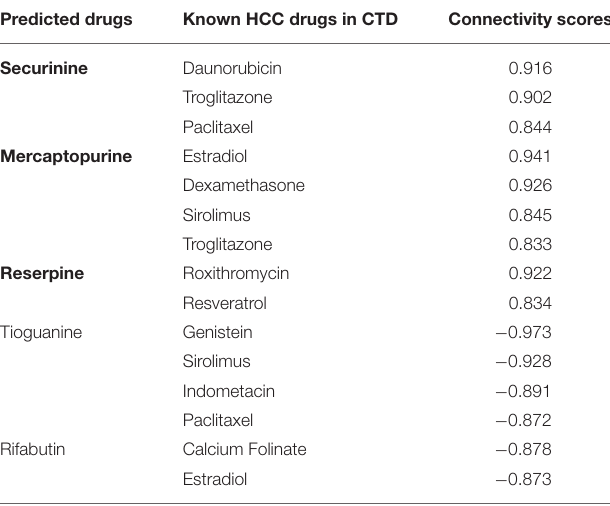
TABLE 4 | The relationships of five predicted drugs with known HCC therapeutic drugs in CTD.